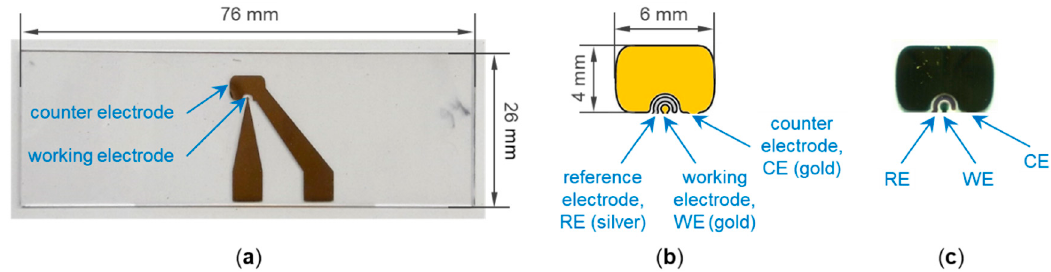
Figure 1. ( a ) Microscope glass slide with sputtered electrodes. ( b ) Detailed view of working and counter electrode, including a potential reference electrode. ( c ) Realized three-electrode setup sputtered on glass.